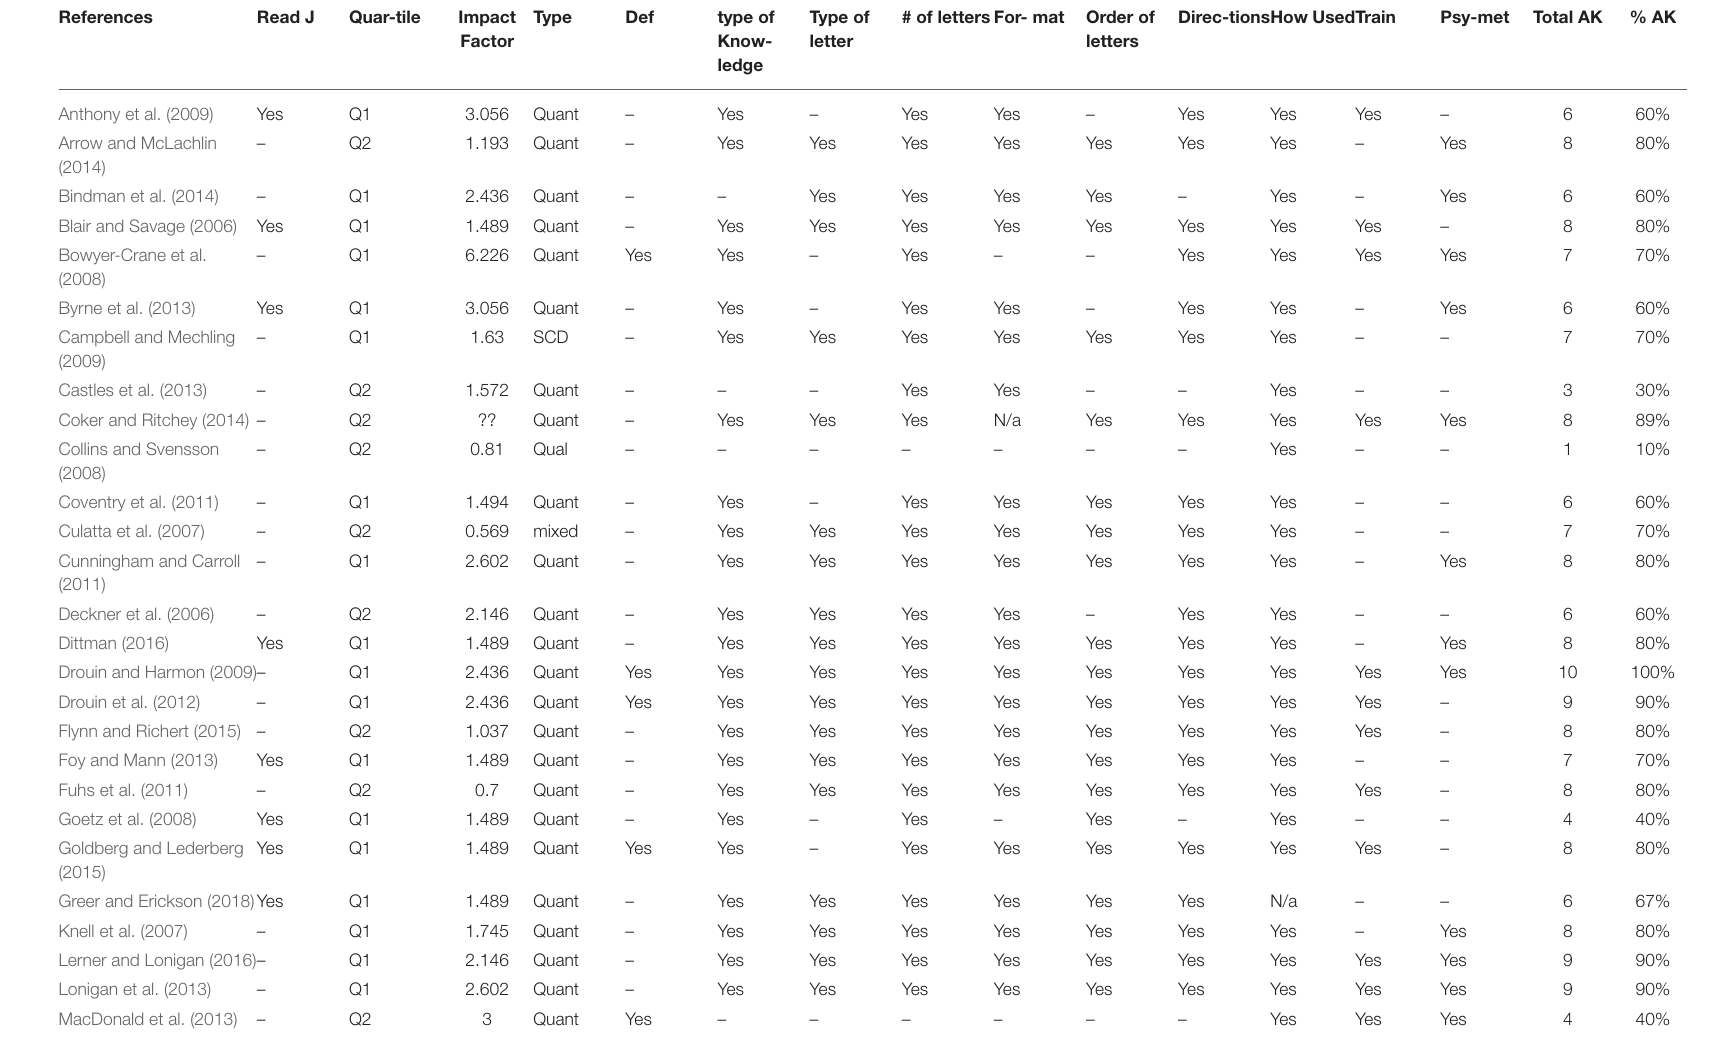
TABLE 1 | Journal information related to AK